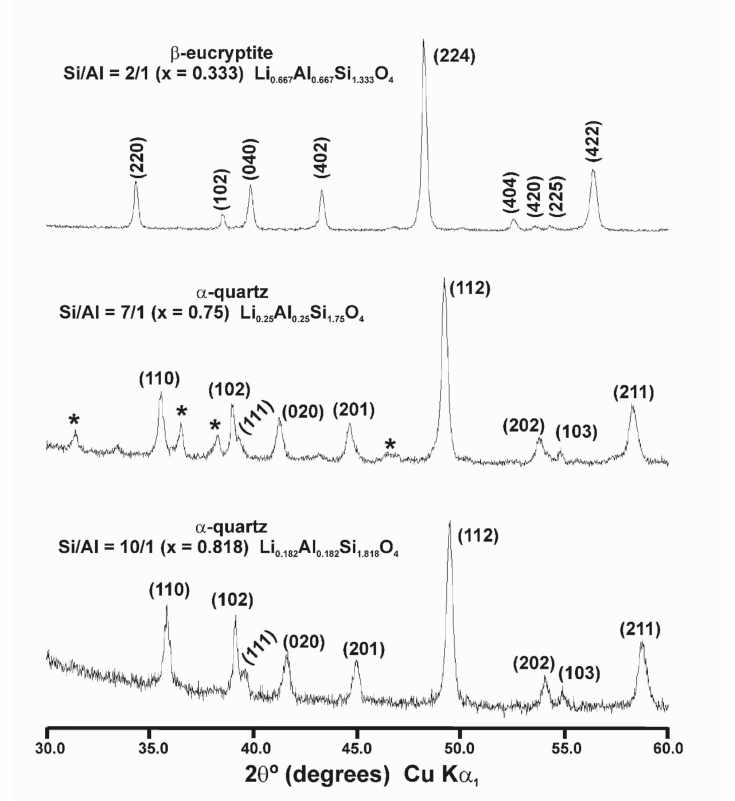
Figure A6. Powder XRD pattern of three samples crystallized by the ceramic method at 850 ◦ C showing the diffractions of the α -quartz and β -eucryptite phases, * for Li–Al-rich cristobalite SiO 2